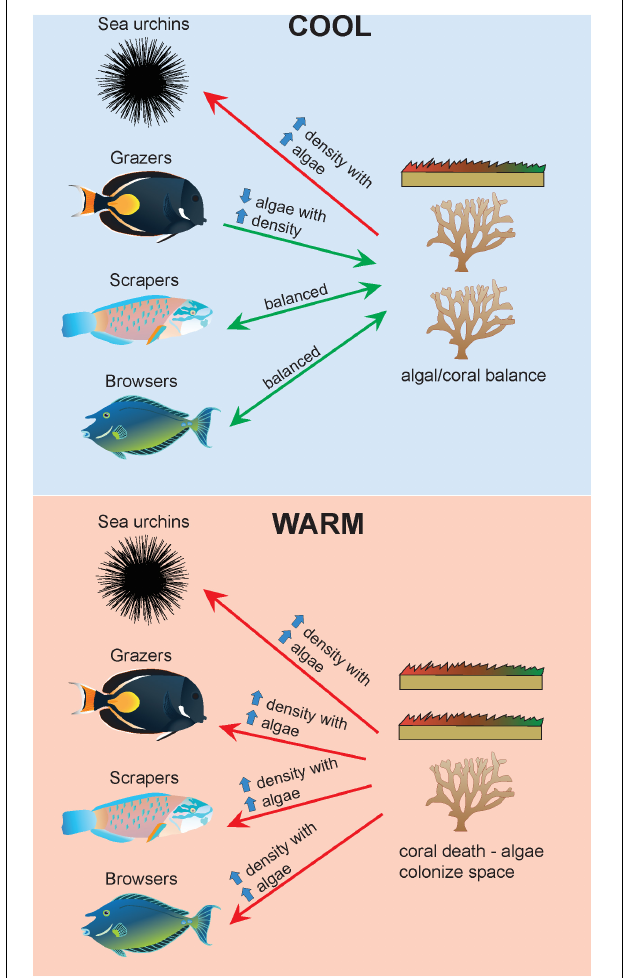
FIGURE 6 | Changes in benthic-herbivore relationships across cool (top panel) and warm (bottom panel) years. In cool years, there is a balance between coral and algal turf cover. Increases in grazers are associated with decreased algal turf cover, while the opposite relationship is seen with sea urchins. In warm years, coral mortality opens space up for algae to colonize. Due to increases in animal metabolism and tracking of resources, there are increases in density across all herbivore groups with increases in algal turf cover. Green arrows indicate top-down control of algal turf cover or balanced relationships. Red arrows indicate insufficient top-down control of algal turf cover. Symbols courtesy of the Integration and Application Network, University of Maryland Center for Environmental Science